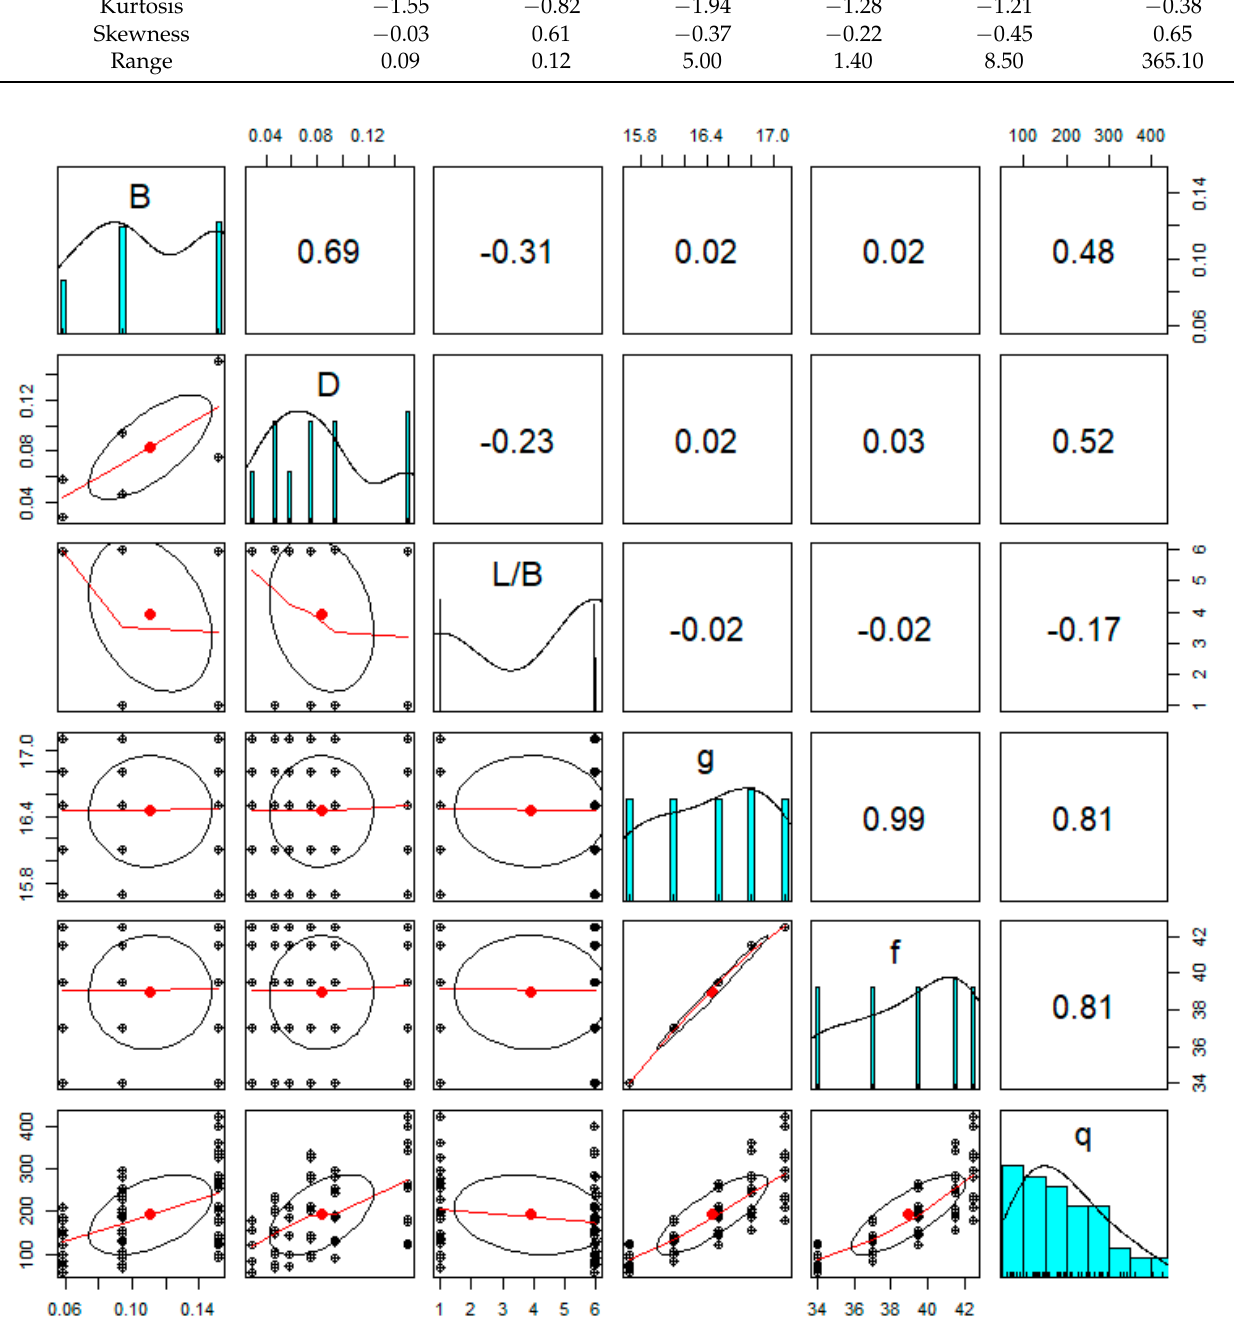
Figure 1. Histogram of the dataset.